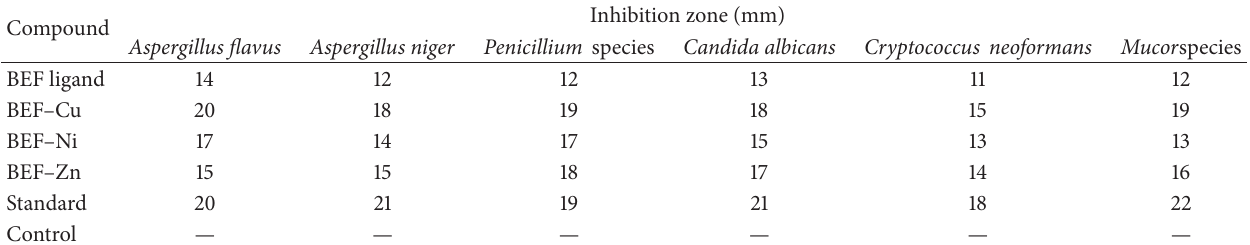
Table 8: Antifungal activity of BEF ligand and its